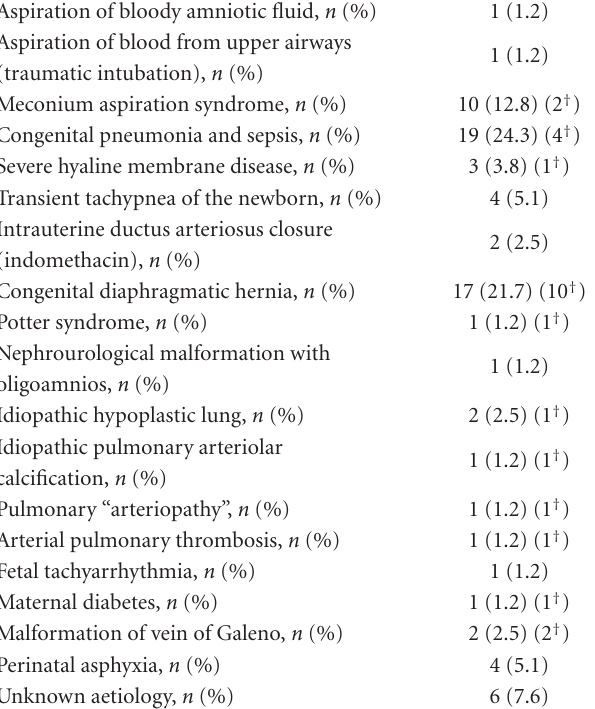
Table 2: Causes of PPHN ( n = 78).